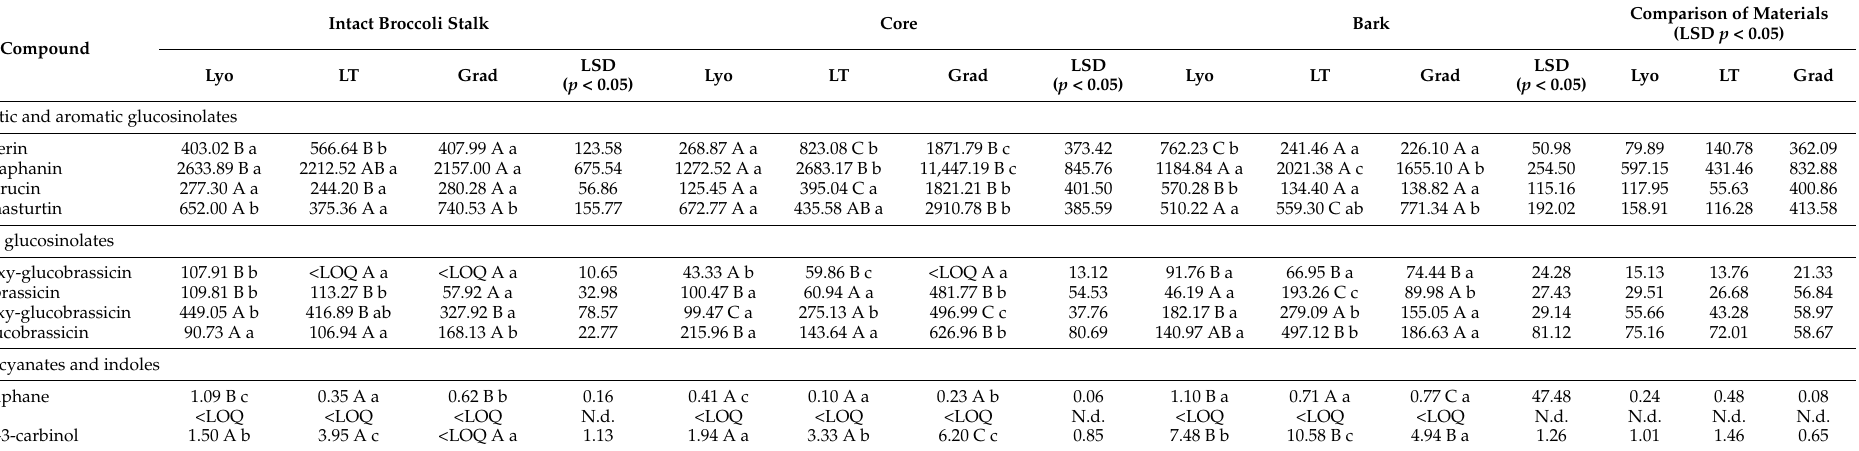
Table 4. Content of organosulfur compounds (mg/kg dw) of fresh, standard-dry, and gradient-dry intact broccoli stalks, broccoli stalk’s core, and broccoli stalk’s